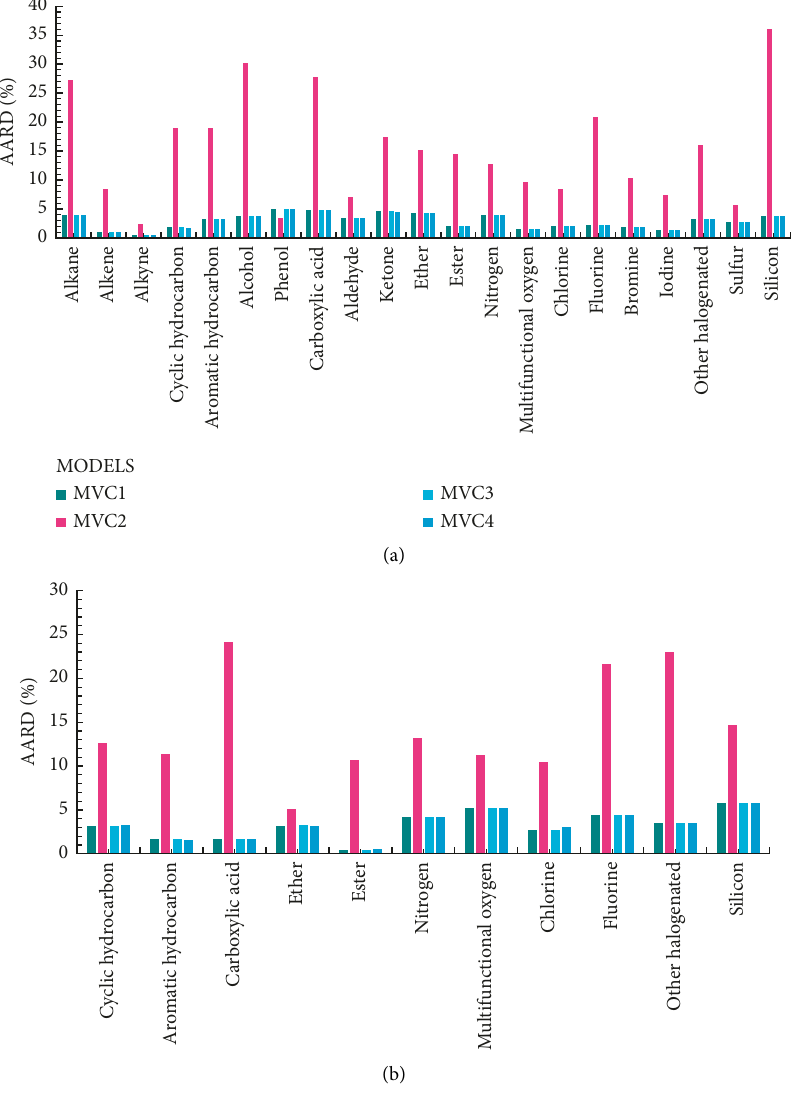
Figure 8: AARD for the calculation of critical volume of pure compounds using different first-order GCMs. (a) Correlation and (b)